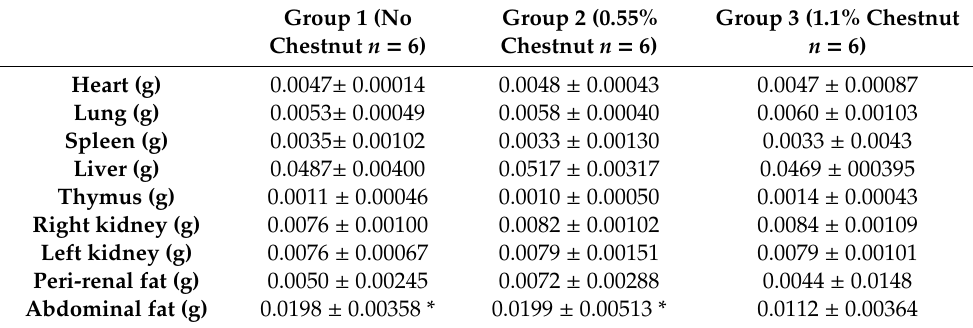
Table 3. Relative organ weights, peri-renal, and abdominal adipose tissue (mean ± standard error).